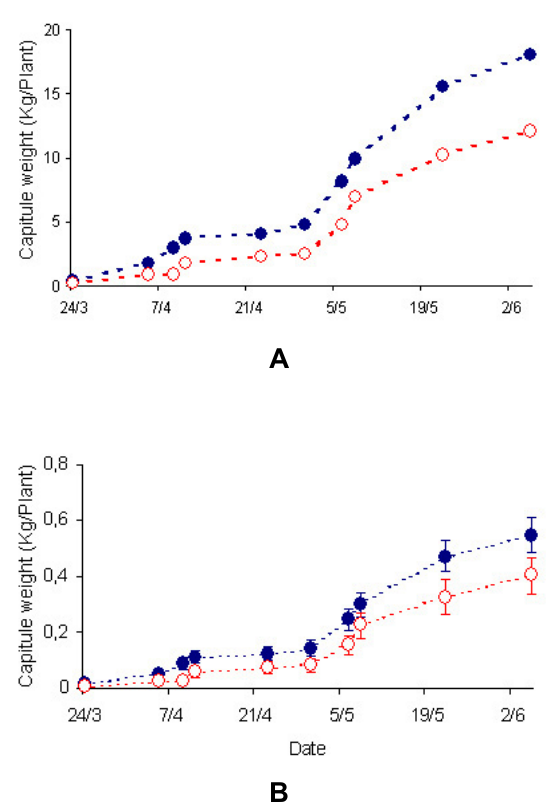
FIGURE 2 . (A) Total production in the field (kg per treatment). (B) Mean and standard error of individual plant production. Blue circles indicate artichoke plants coming from charcoal-filtered air; red circles indicate artichoke plants coming from nonfiltered air. No statistically significant differences were found; one-way ANOVA (p < 0.05)